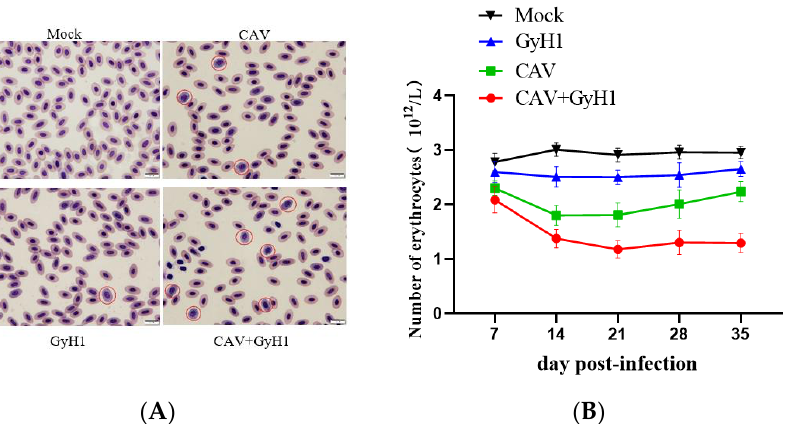
Figure 3. Erythrocyte morphology and count. ( A ) Erythrocytes were observed with Swiss–Giemsa staining, 100×. The rounded, basophilic and thus appearing blue is proerythrocyte, which is indicated by a red circle. ( B ) Dynamic changes of erythrocyte number in each group determined by routine analysis of blood.